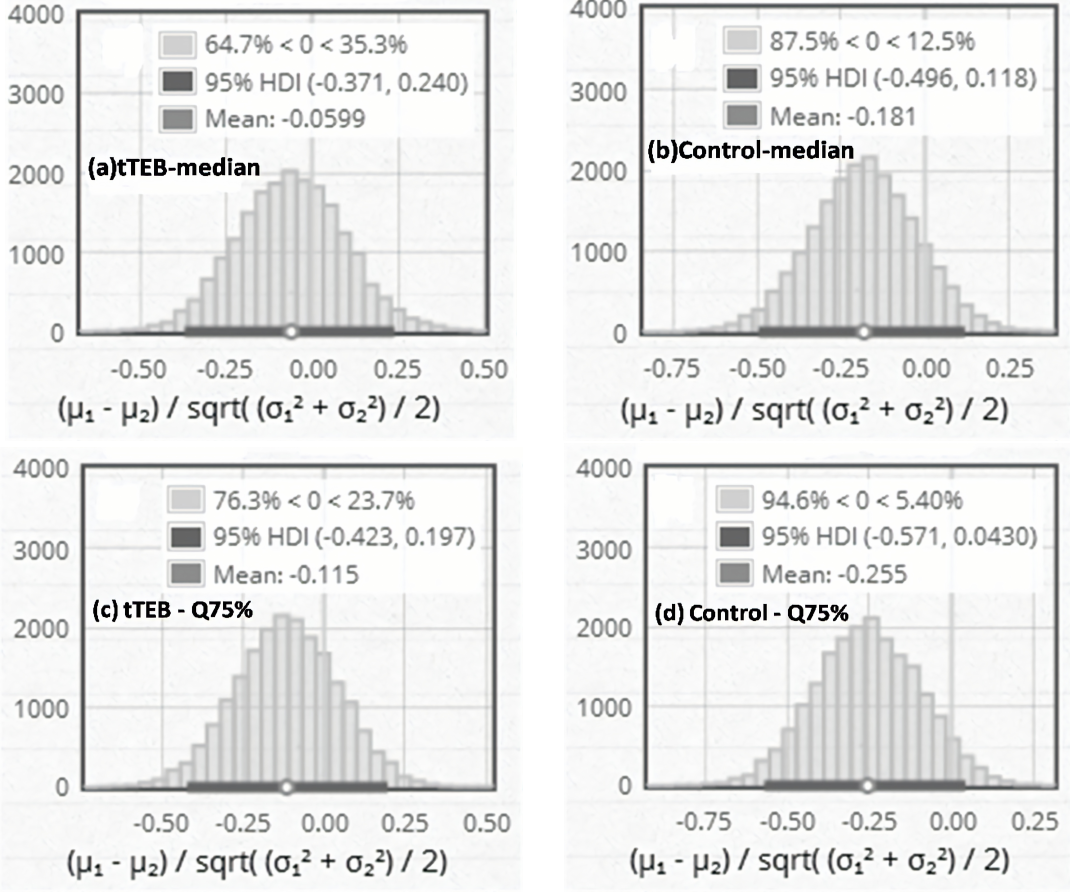
Figure 9. Histogram distribution of effect size parameter (Equation (2)) between median and quantile 75% rainfall results of ( a , c ) tTEB and ( b , d ) control experiments with median and quantile 75% rainfall estimates of weather radar. The two data groups are shown in Figure 7a,b, respectively. These figures were made using the version online of the Bayesian Estimation Supersedes the t-test (BEST) http://sumsar.net/best_online/ providing the rainfall data. This page was made by Rasmus Baath, at Lund University Cognitive Science,